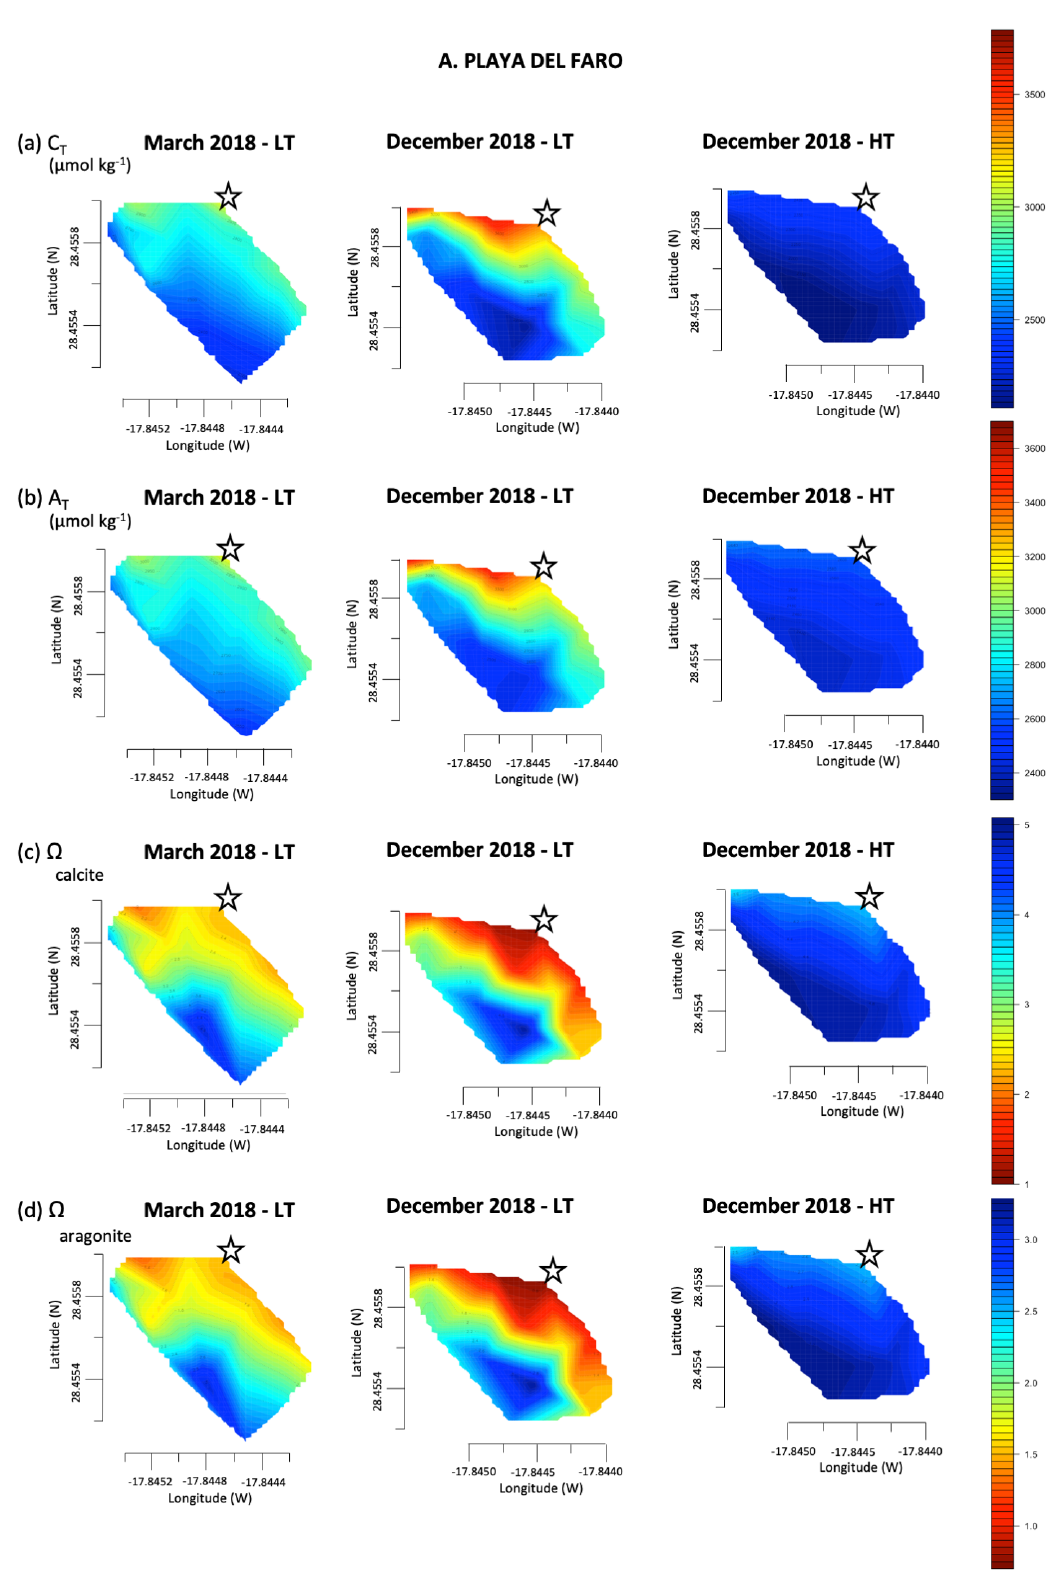
Figure 3. Linear interpolation graphs of C T (a) , A T (b) , (cid:127) calcite (c) and (cid:127) aragonite (d) values during March 2018 and December 2018 during low tide (LT) and high tide (HT) on Playa del Faro. The star symbol is the reference mark on the map in Fig.